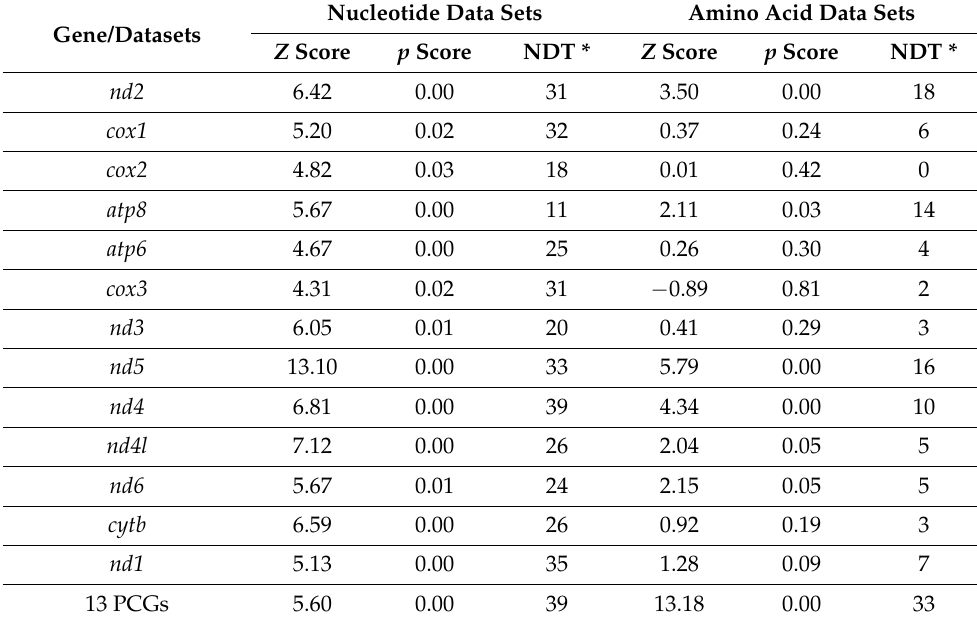
Table 4. Results of Posterior Predictive Test on individual mitochondrial genes. Nucleotide Data Sets Amino Acid Data Gene/Datasets